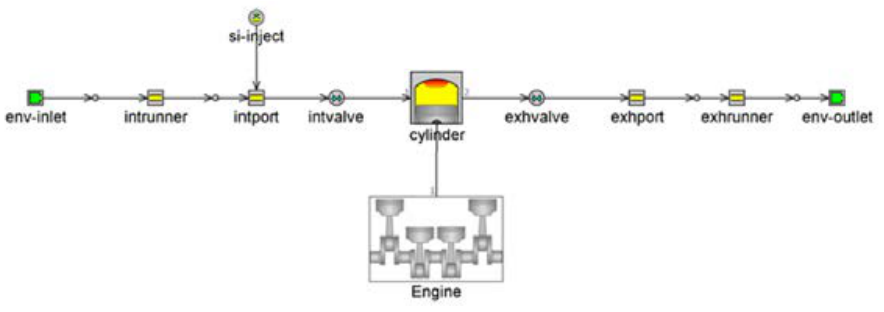
Figure 1. Simulation model of SI engine. Table 2. Engine specifications.